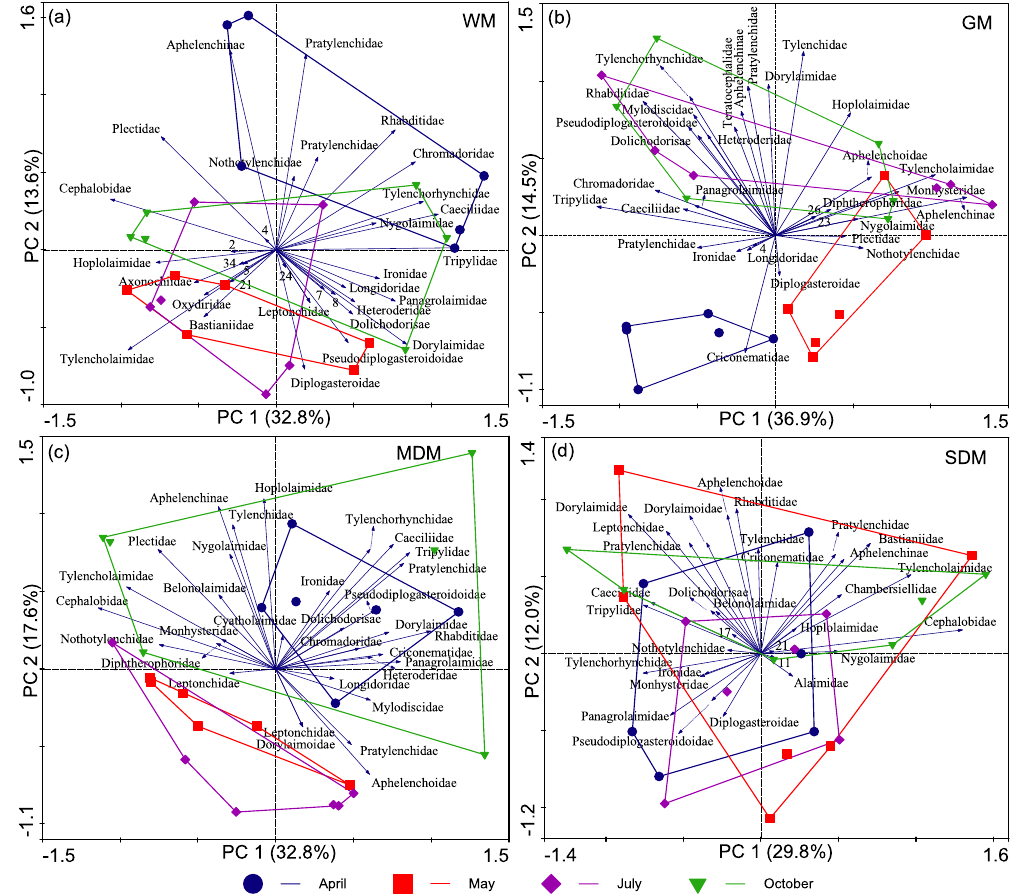
Figure 3. Seasonal variations in community structure of the soil nematodes of Zoigê Wetland. Short arrows indicating rare taxonomic groups were omitted for